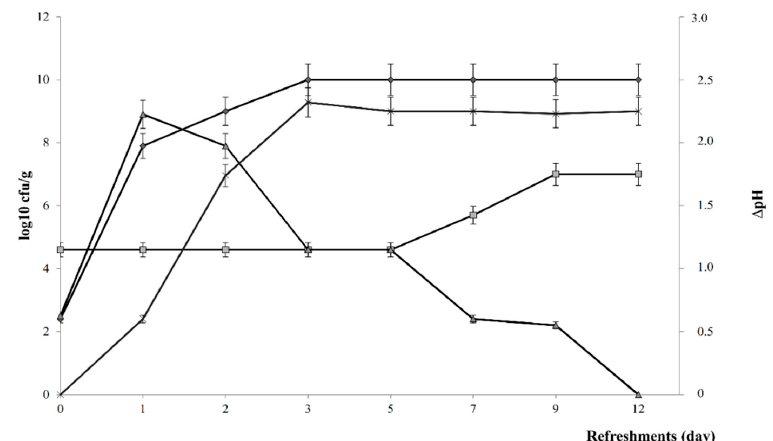
Figure 1. Cell density (log10 colony forming units (cfu)/g) of presumptive lactic acid bacteria (circle), yeasts (square) Enterobacteriaceae (triangle) and kinetic of acidification (star) of the teff type-I sourdough. Sourdough was daily propagated for twelve days and 0, 1, 3, 5, 7, 9, and 12 identified the dough (after mixing and before fermentation) and sourdough after one, two, five and ten days of propagation. Data are the means of three independent batches analysis ± standard deviations (n = 3). Bars of standard deviations are also